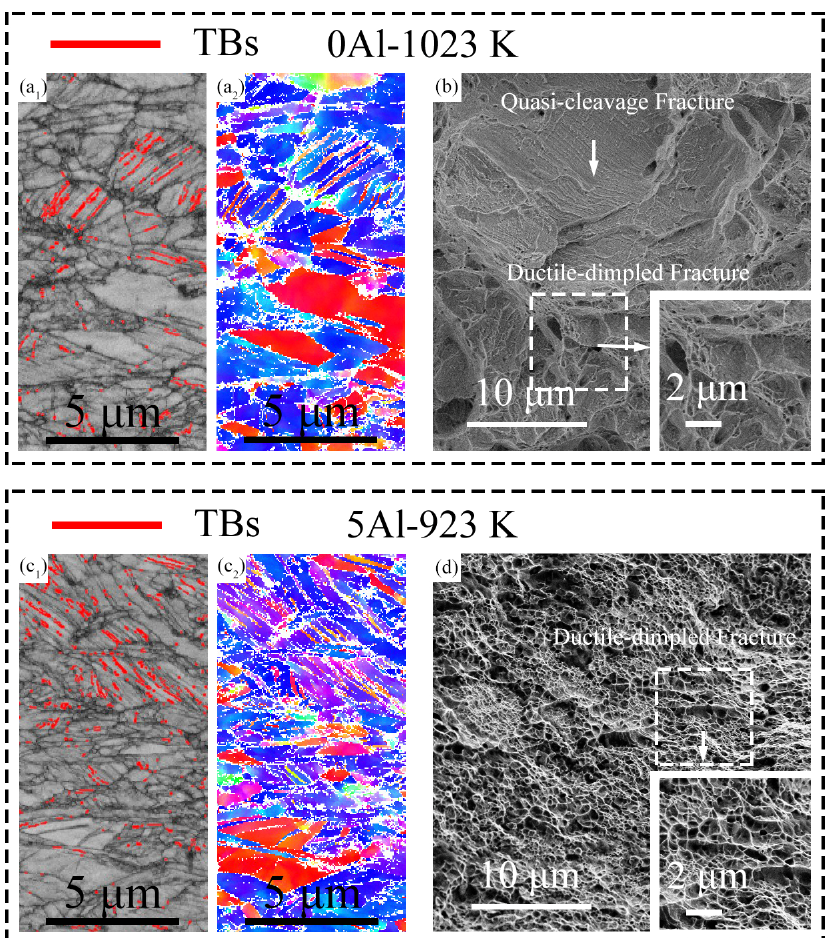
Figure 5. EBSD ( a1 ) IQ and ( a2 ) IPF maps near the fracture region of the 0Al-1023 K specimen; ( b ) SEM fracture micrograph of the tensile-fractured 0Al-1023 K specimen. EBSD ( c1 ) IQ and ( c2 ) IPF maps near the fracture region of the 5Al-973 K specimen; ( d ) SEM fracture micrograph of the tensile-fractured 5Al-973 K specimen.